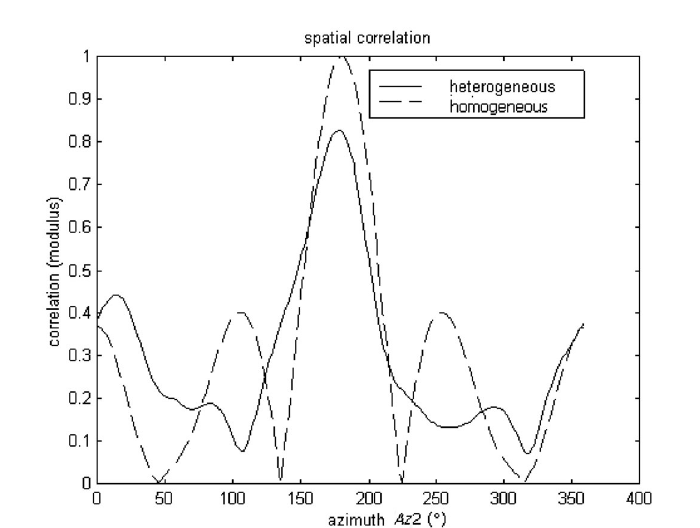
Fig. 13.8. Comparison of the spatial correlation of